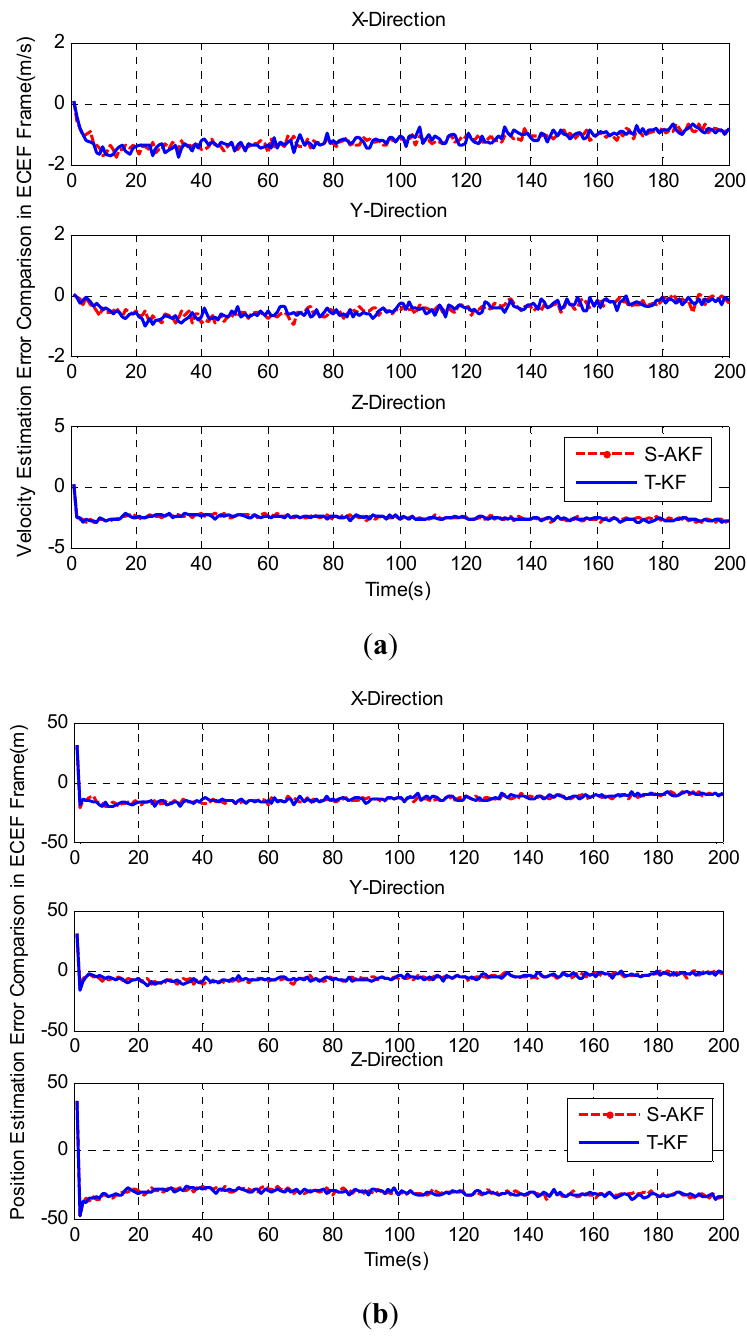
Figure 8. ( a ) Velocity estimation errors of S-AKF and T-KF in ECEF frame; ( b ) Position estimation errors of S-AKF and T-KF in ECEF